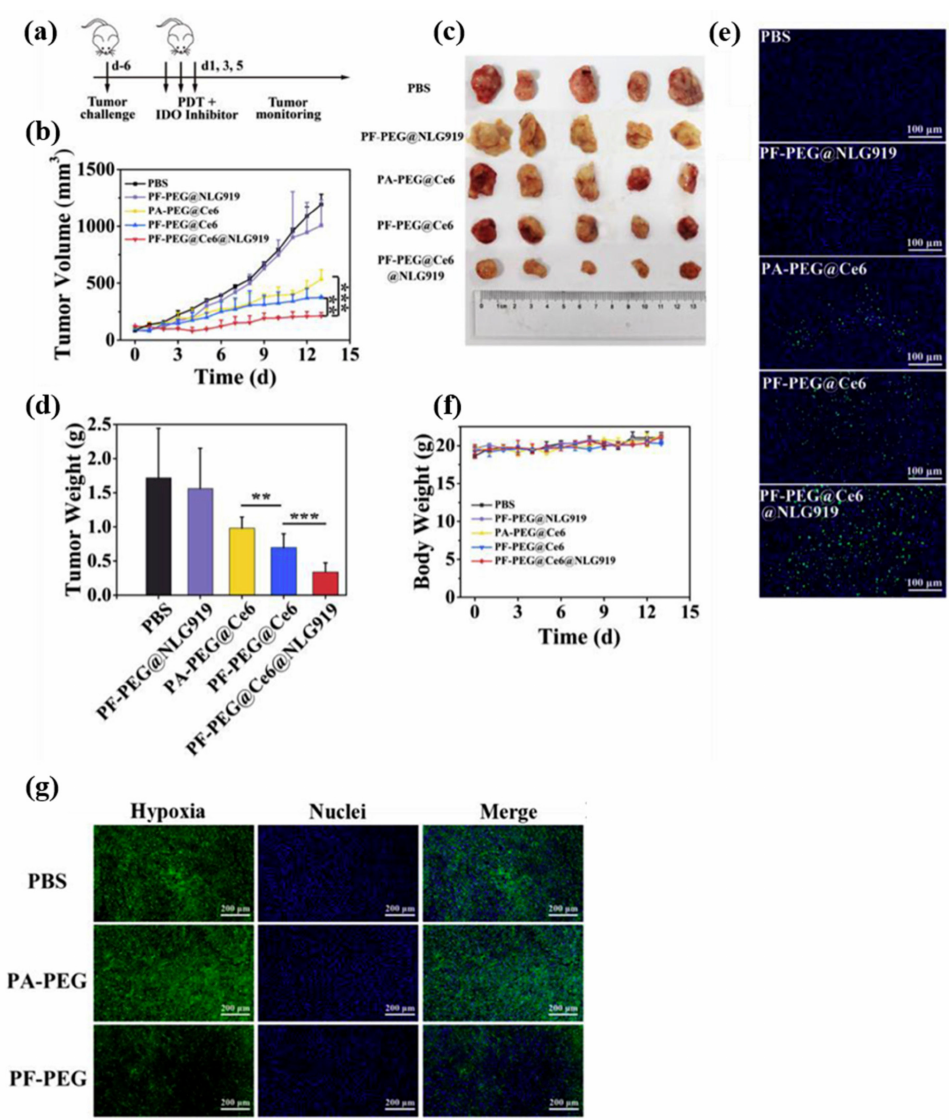
Figure 2. ( a ) The diagram of dosage regimen. ( b ) Inhibition of 4T1 tumor growth by PDT and IDO in- hibitor. Tumor-bearing mice were intratumorally injected with oxygen-saturated PF-PEG@Ce6@NLG 919, and the tumor sites were illuminated (660 nm, 55 W/cm 2 ). ( c ) Photograph of the tumors removed on day 14. ( d ) The weight of the tumor treated with different formulations on the last day. ( e ) TUNEL staining of tumor sections. The green light spots represent DNA damage tagged on FITC; the blue represents the nucleus labeled with DAPI. ( f ) The body weight of the mice. p values: ** p < 0.01, *** p < 0.001, one-way ANOVA, n = 5. ( g ) Immunofluorescence staining of tumor sections to detect whether the PF-PEG group could improve hypoxia in vivo. The nucleus and the anoxic region were stained with DAPI (blue) and SOSG (green), respectively. Reproduced with permission [74]. Copyright 2019, Elsevier